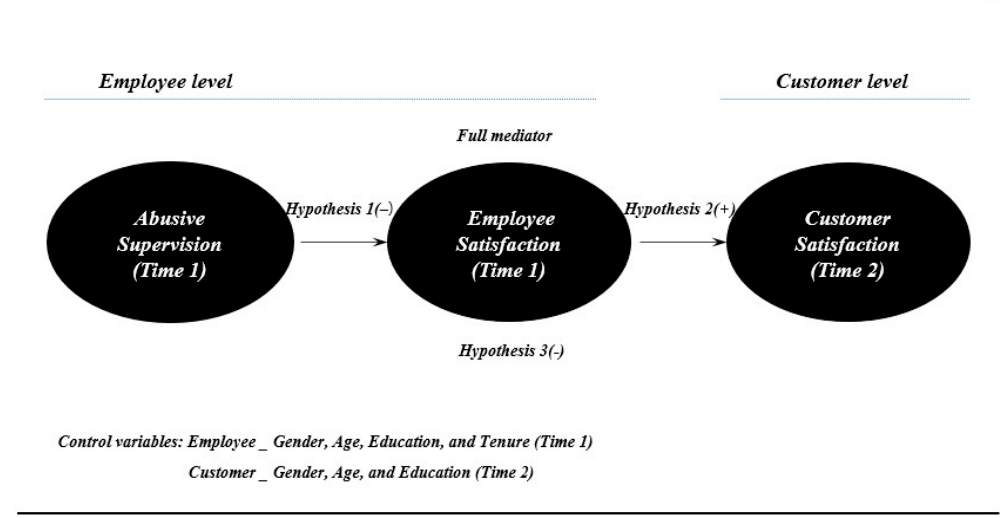
Figure 1. Research model.